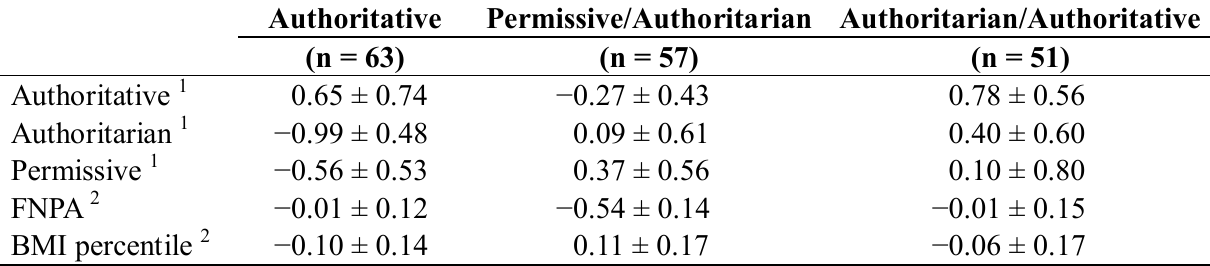
Table 2. Cluster by scores in parenting style, FNPA and BMI percentile